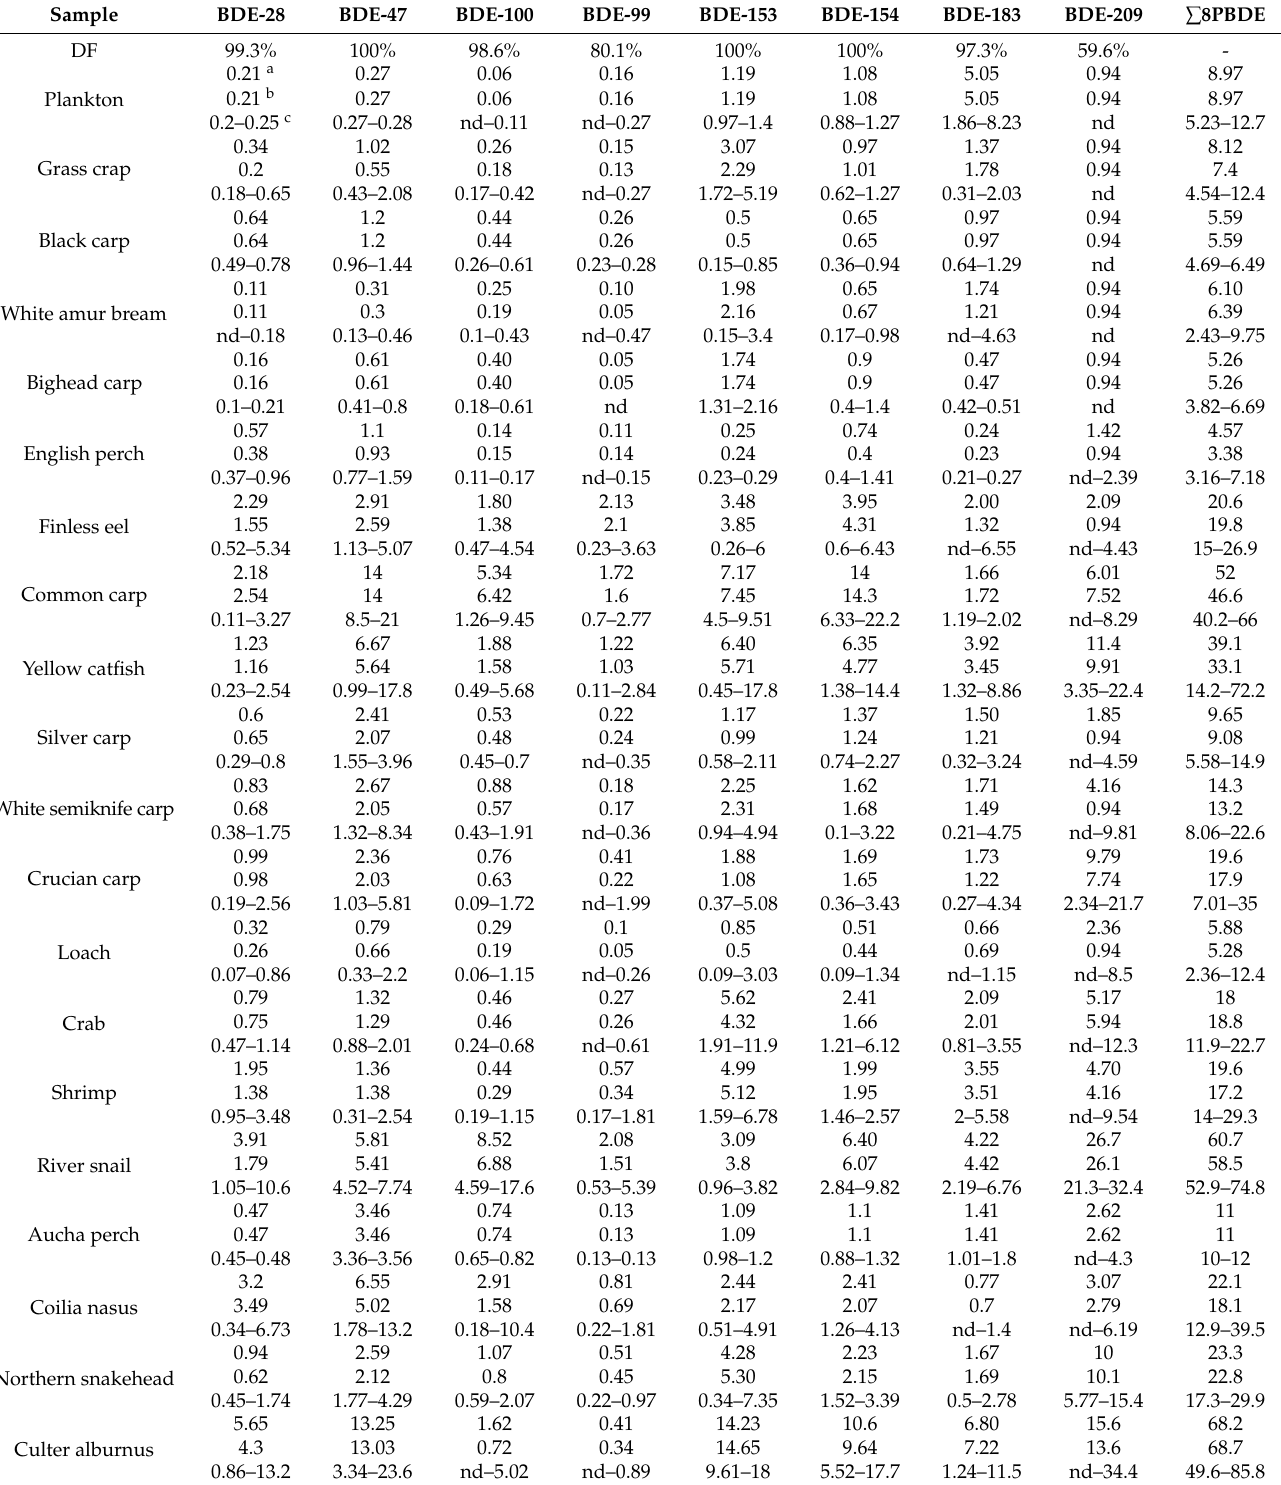
Table 1. Concentrations of PBDE congeners (ng/g lipid weight) in aquatic organisms from typical shallow lakes in January